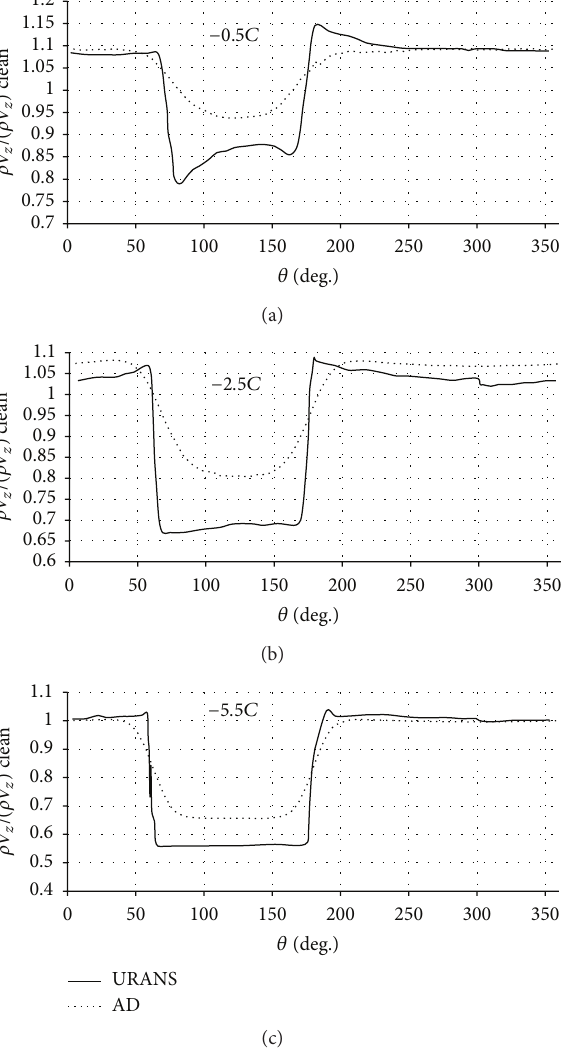
nodes. NASA Rotor 67 can be fitted inside this nacelle. The total mesh, including the nacelle plus the full 22 passage Rotor 67, contains 6254269 elements and 6034624